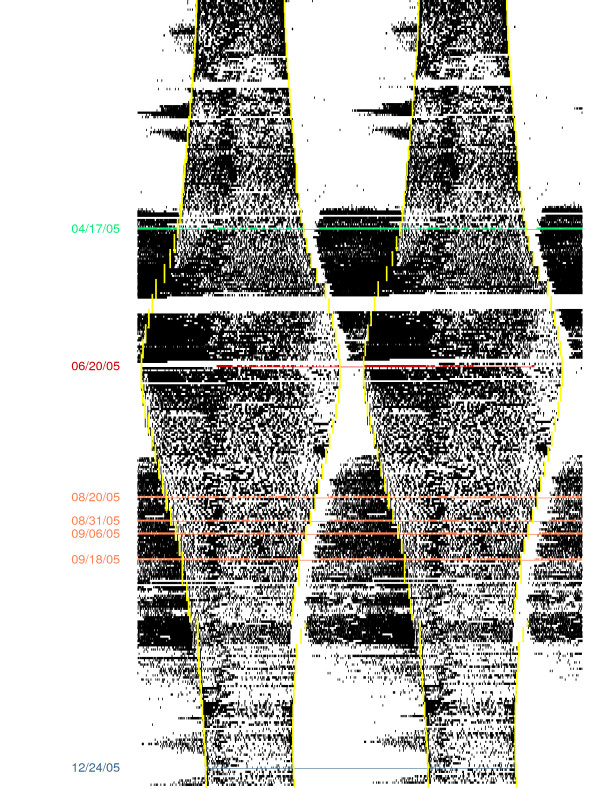
This double plotted actogram shows activity for a representative bird over the course of approximately 30 months, including 2005 when the sleep data for this paper were collected. Vertical yellow lines indicate seasonal changes in daylight. Seasons from which birds were selected for sleep analyses are highlighted (winter (blue) n = 4, spring (green) n = 5, summer (red) n = 4, fall (brown) n = 3). Photoperiods for the winter, spring, summer, and fall seasons were, respectively, 9.5:14.5 LD, 14.75:9.25 LD, 21.5:2.5 LD, and 13.75:10.25 to 16.0:8.0 LD.